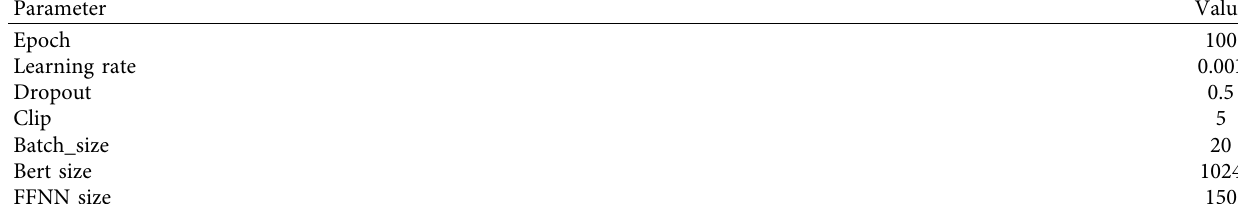
Table 5: The statistical results of different entities in the dataset.